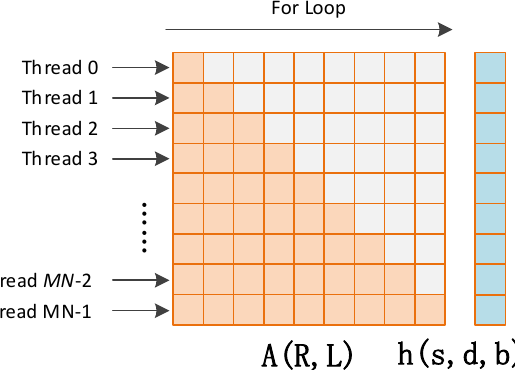
Figure 8. Architecture of the Cholesky solver.